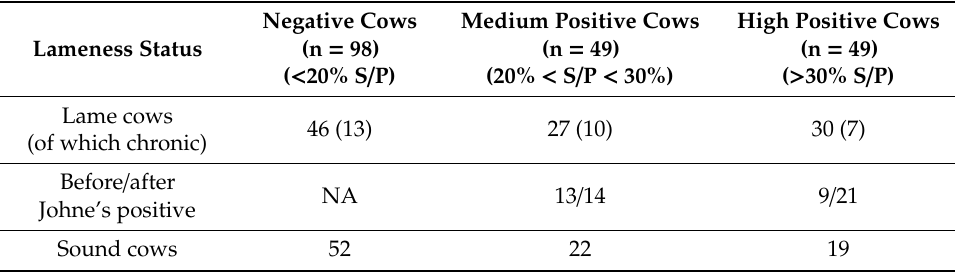
Table 1. Number of lame and sound cows based on Johne’s